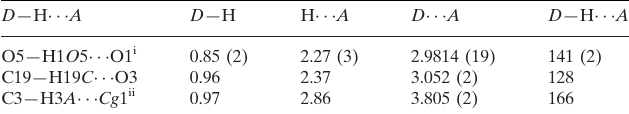
Hydrogen-bond geometry (A˚ , (cid:3)